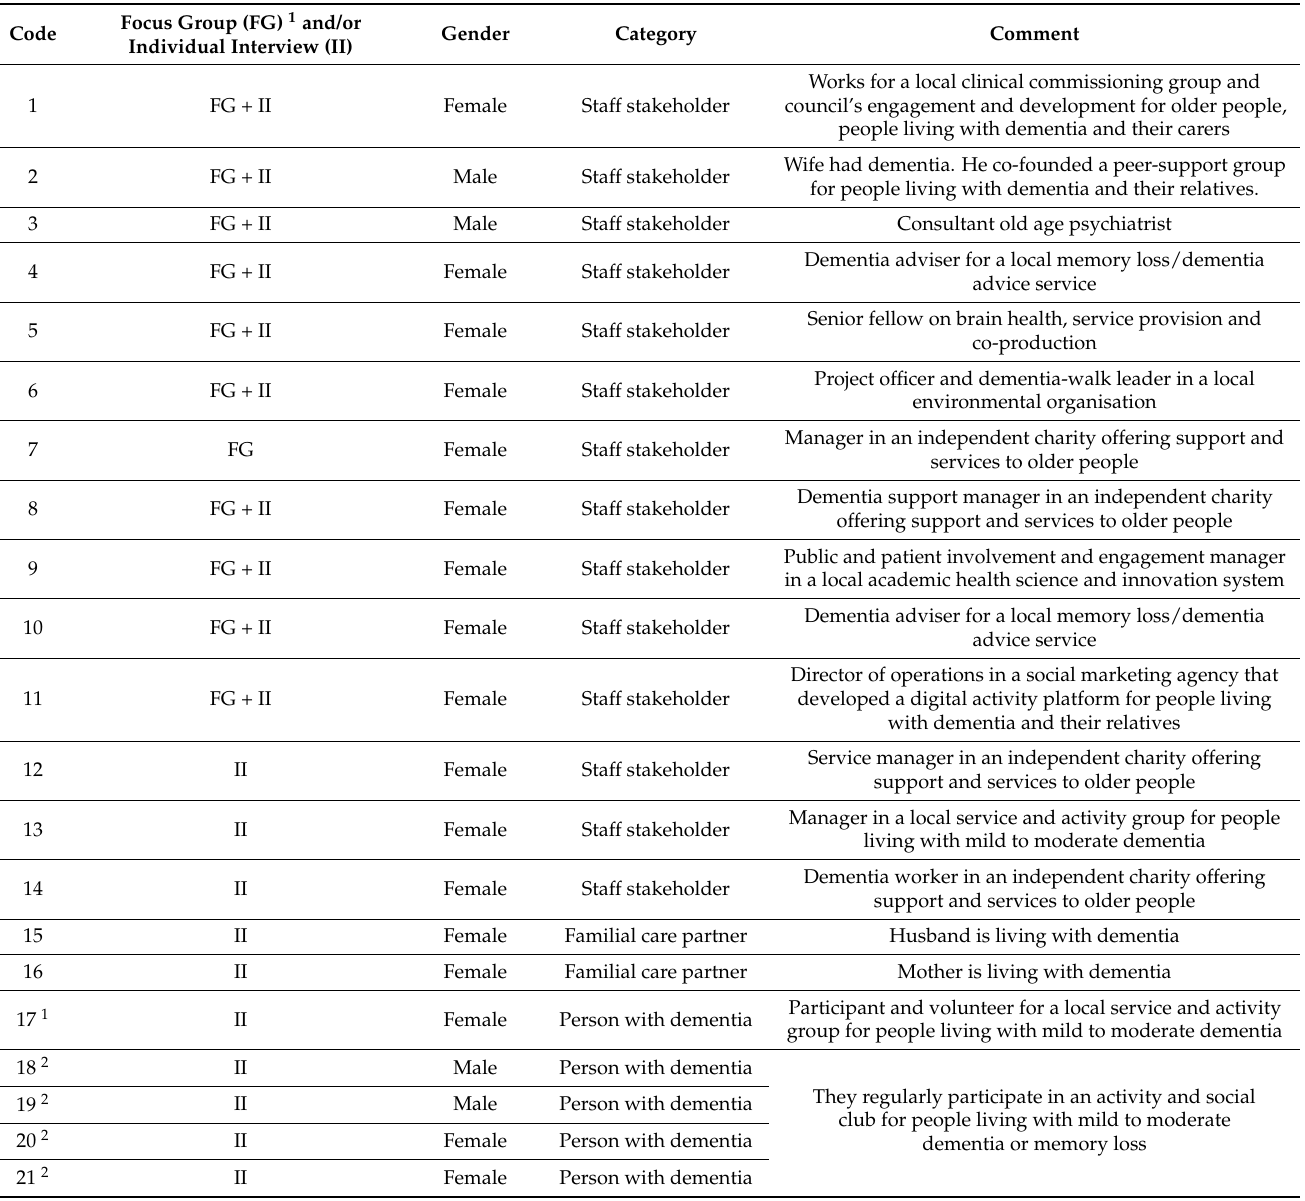
Table 1. Participants’